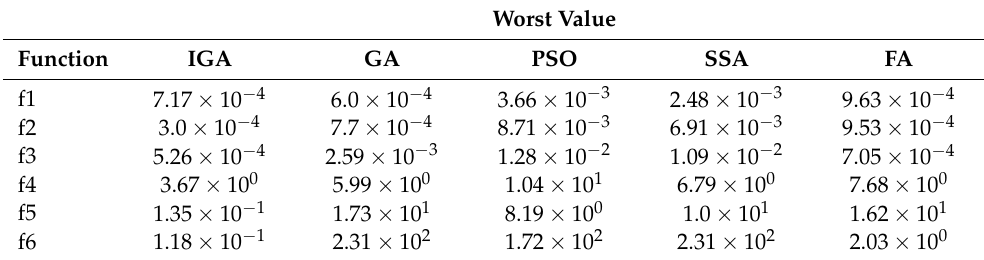
Table 4. Mean different of test functions about six algorithms.